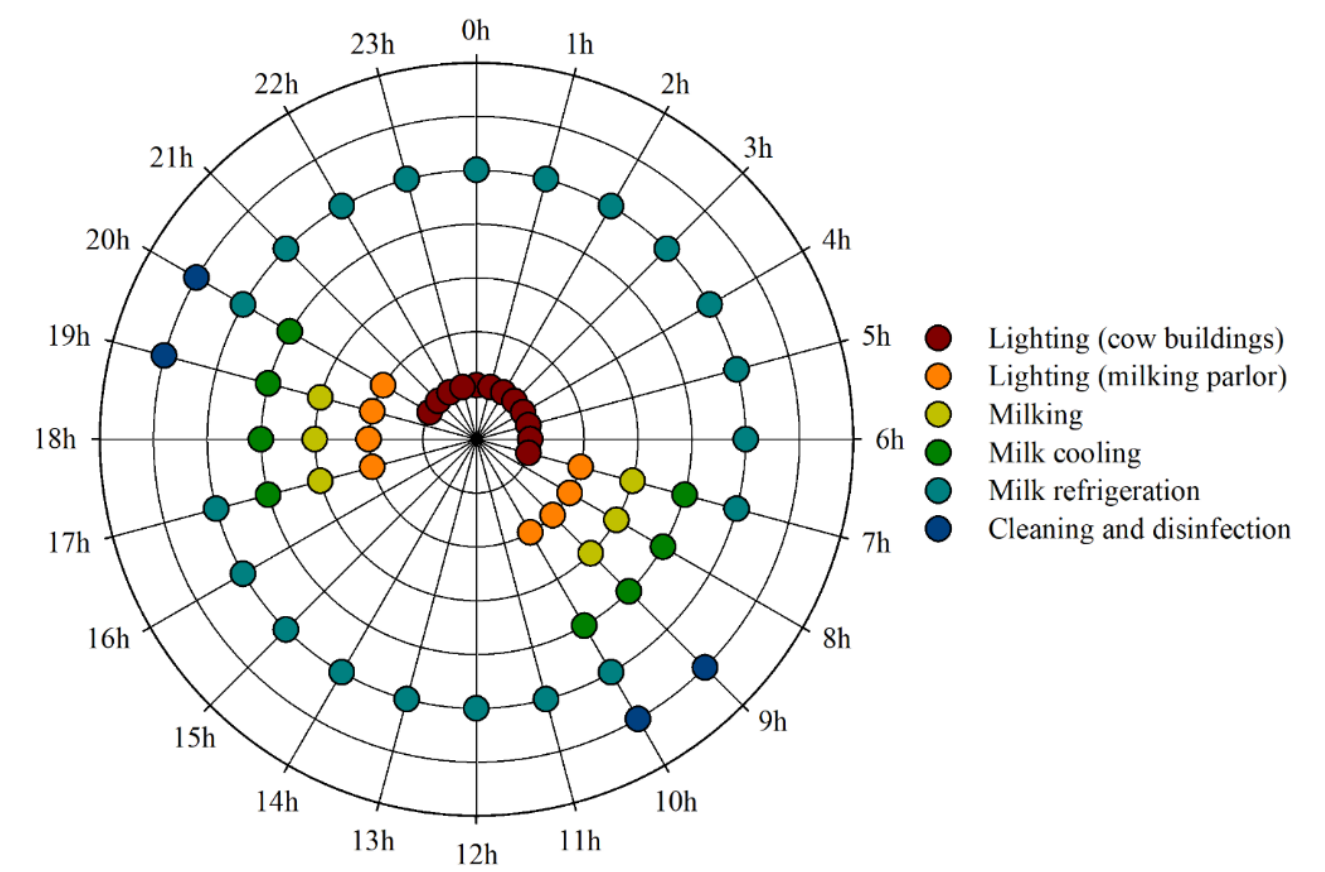
Figure 1. Average daily profile of the dairy activities in Brazilian farms.